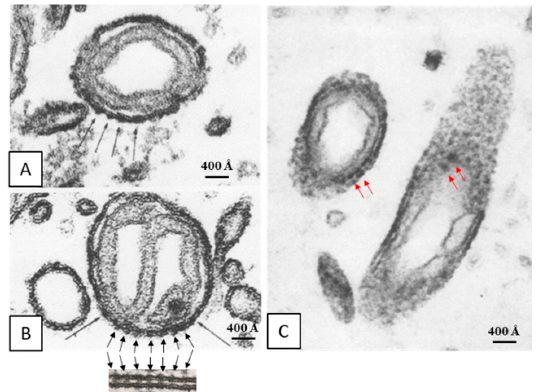
Figure 3. Freeze-fracture images of gap junctions between rat liver ( A ) and stomach ( B ) epithelial cells showing membranes of cytoplasmic cisterns ( C ) apparently attached to gap junction membranes. P, Protoplasmic face; E, Exoplasmic face. A from [18]; B from [17].